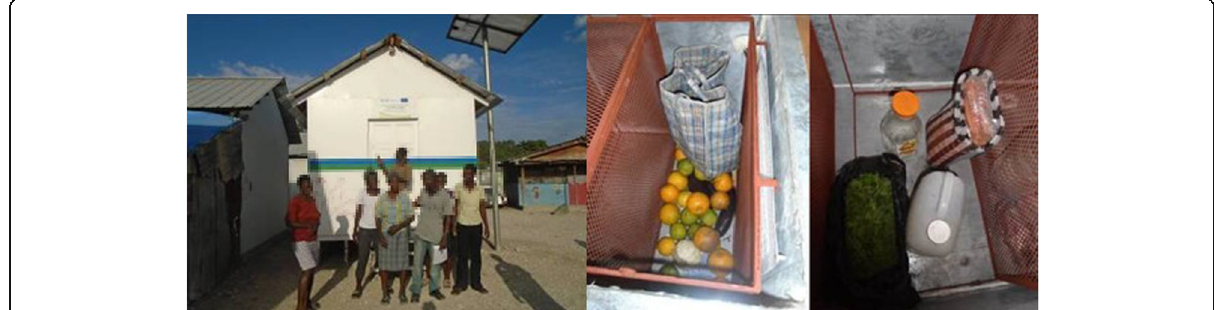
Fig. 9 SPARK refrigerators in